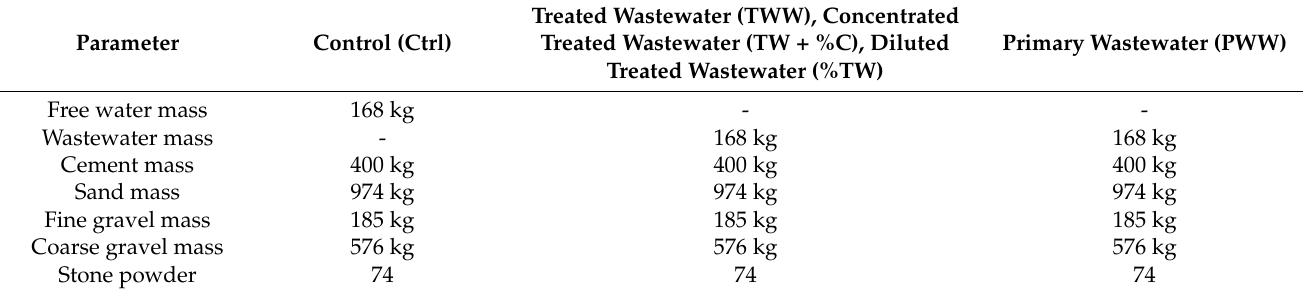
Table 5. Detail of mix design of concrete